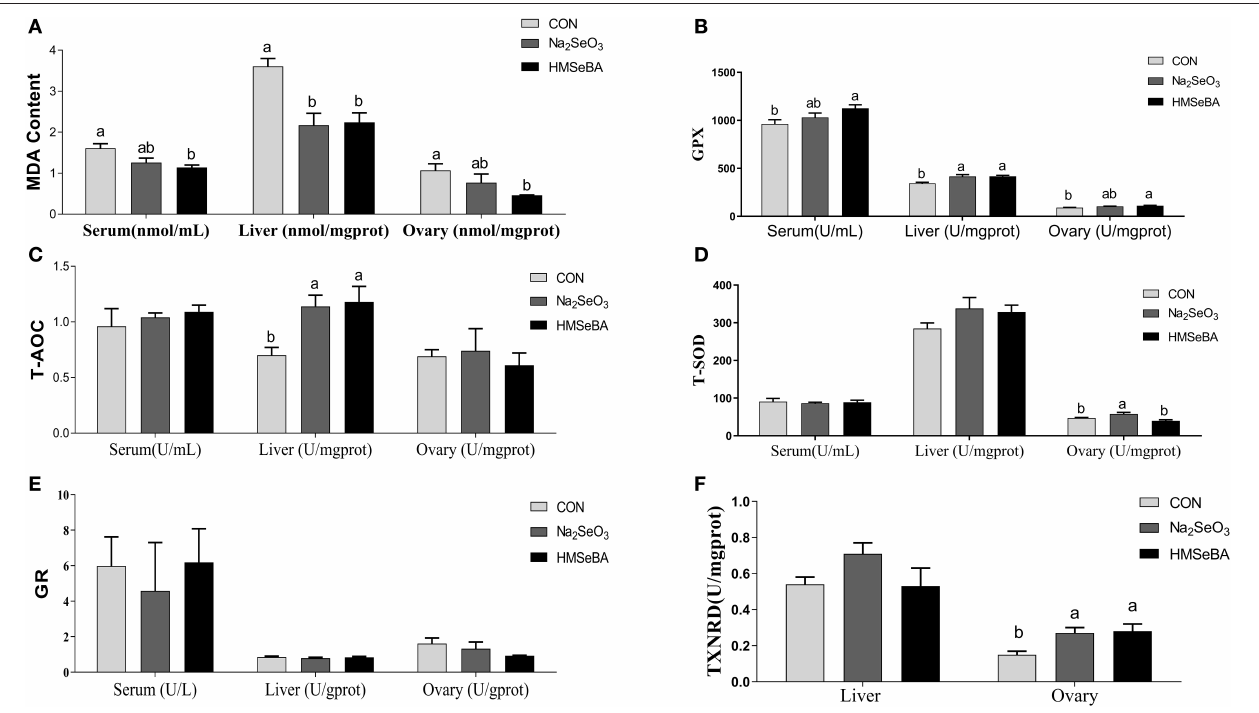
FIGURE 4 | Effects of dietary selenium supplementation on the oxidative status indicators in gilts. (A) MDA, (B) GPX activity, (C) T-AOC, (D) SOD activity, (E) GR activity, and (F) TXNRD in serum, liver and ovary of gilt. Data are expressed as means values and standard error, n = 5. Mean values with different superscript letters were significantly different ( P < 0.05). CON, basal diet; Na 2 SeO 3 , 0.3mg Se/kg Na 2 SeO 3 ; HMSeBA, 0.3mg Se/kg HMSeBA; MDA, malondialdehyde; GPX, glutathione peroxidase; T-AOC, total antioxidant capacity; T-SOD, total superoxide dismutase; GR, gluathione reductase; TXNRD, thioredoxin